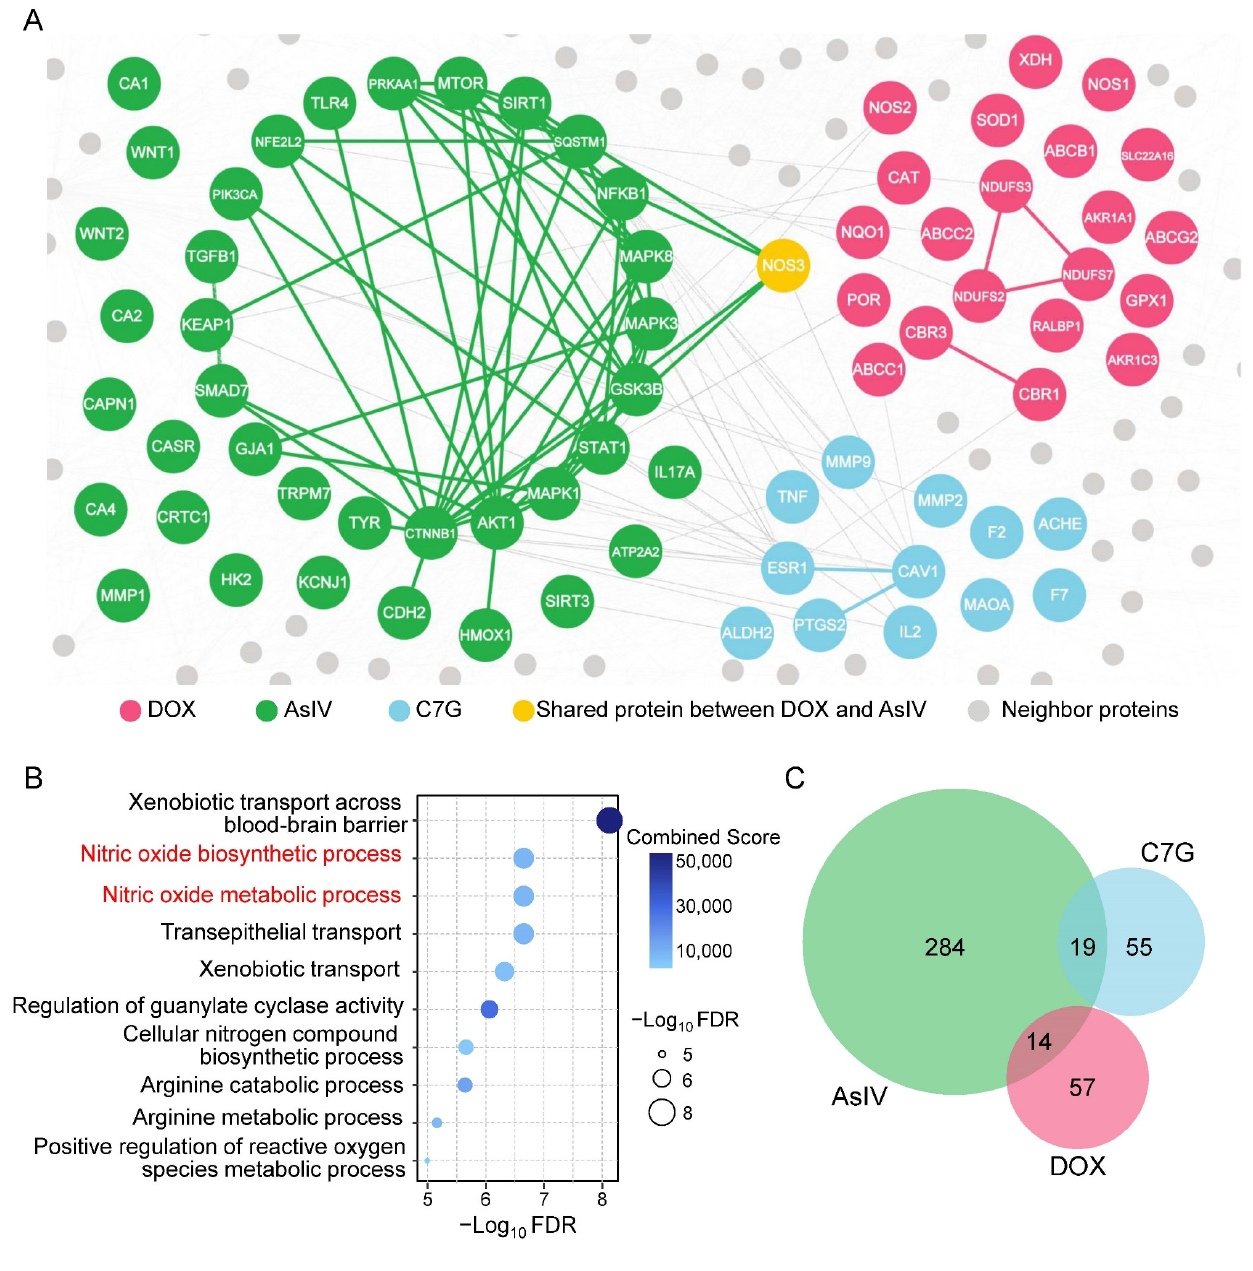
Figure 4. Network-based relationship between Astragali Radix (AR) components and doxorubicin (DOX) disposition. ( A ) A subnetwork of the protein–protein interactome illustrating the network- based separation between DOX, Astragaloside IV (ASIV), and calycosin-7-O-glucoside (C7G). ( B ) Top 10 enriched pathways related to DOX disposition. ( C ) Venn diagram showing little overlap between significantly (FDR < 0.01) enriched pathways of DOX, ASIV, and C7G.